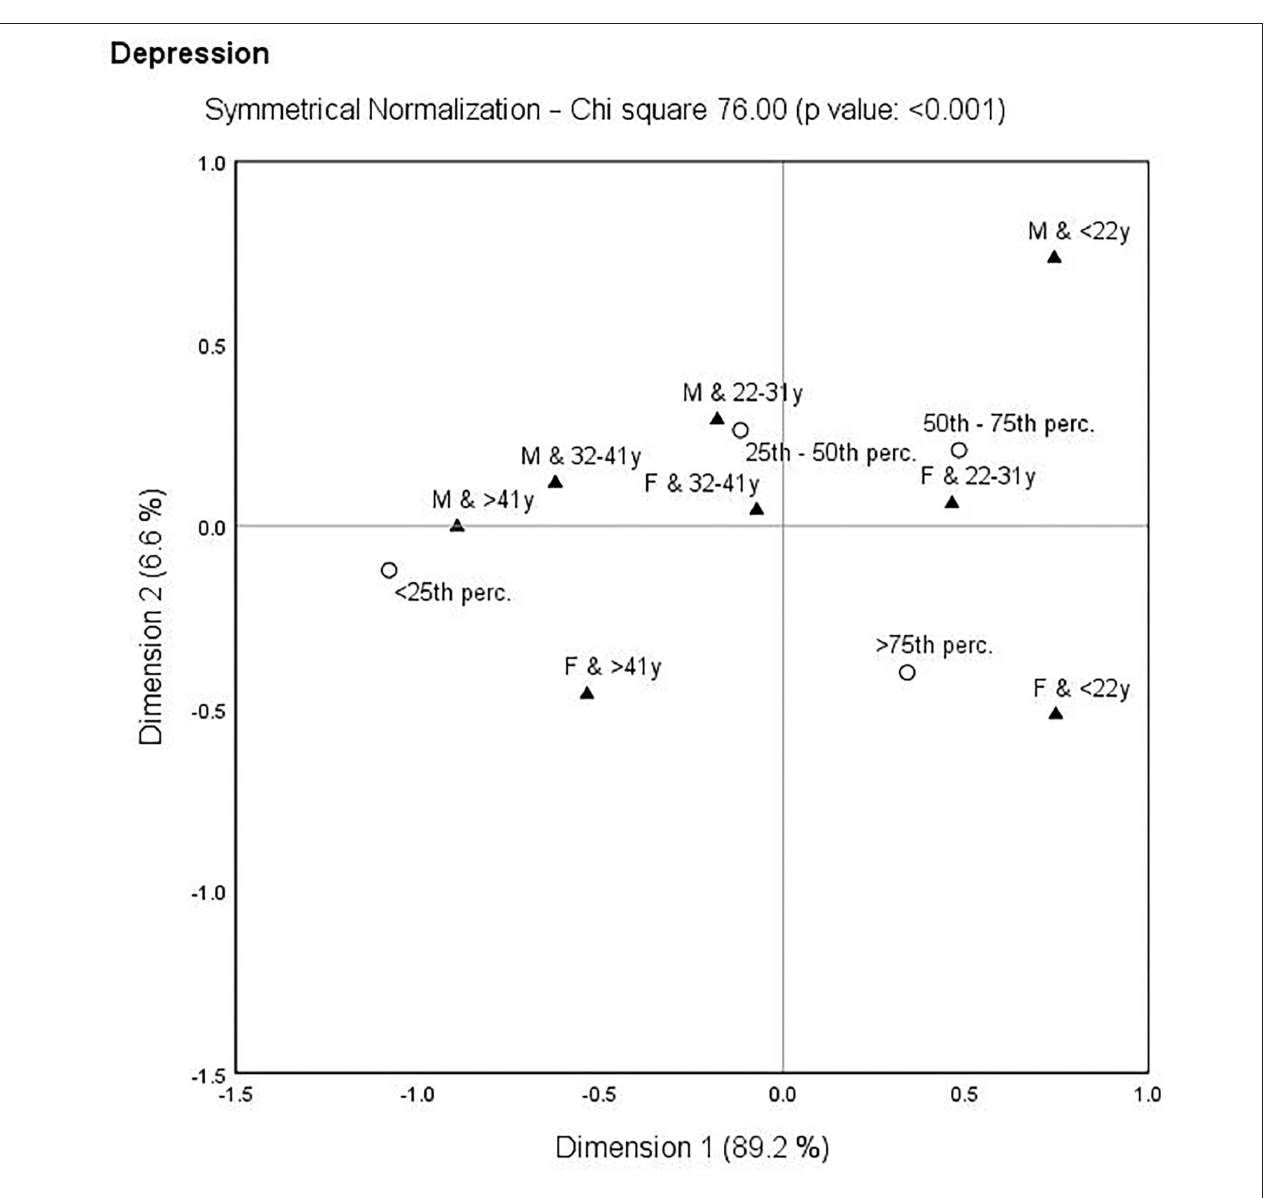
FIGURE 5 | Correspondence map—depression (PHQ-9) and gender-age